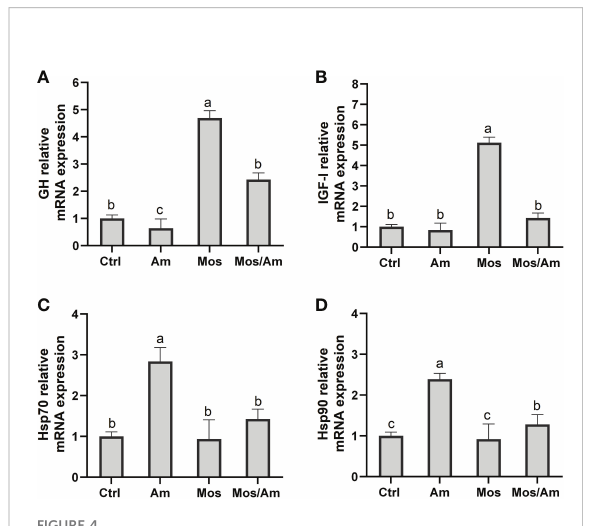
FIGURE 4 Effects of dietary MOS on the mRNA expression of heat shock protein genes of the common carp under ammonia stress for 30 days. Values are expressed as mean ± standard error (SE) from triplicate groups. Bars with different letters differ signi fi cantly from those of other groups (P < 0.05). GH relative mRNA expression (A) ,